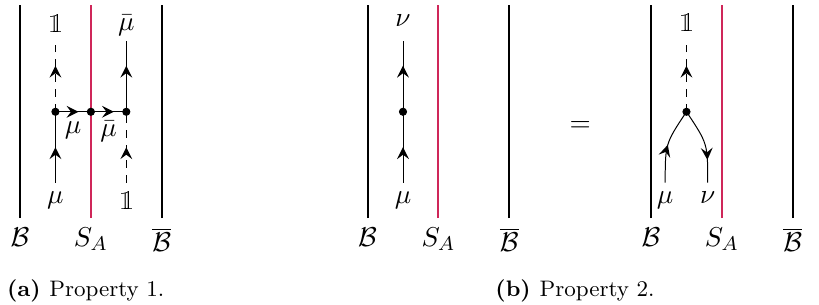
Figure 7. Pictorial proofs of the properties of the (cid:11) -induction.